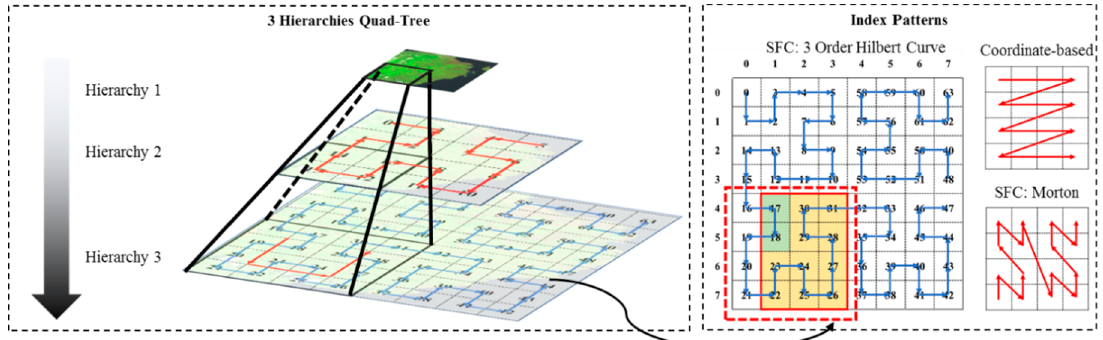
Figure 4. Remote sensing tiles segmentation and linearization.